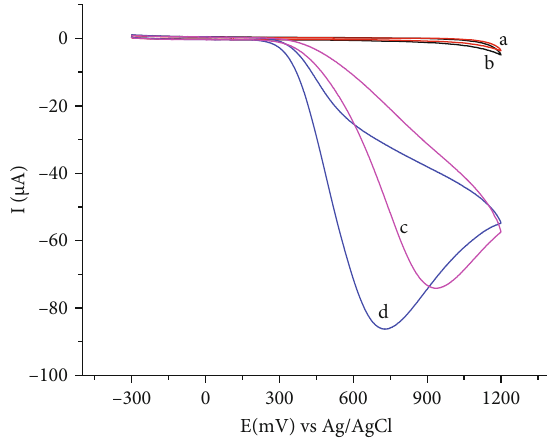
Figure 1: Cyclic voltammograms of (a) UCPE and (b) AQMCPE both in the absence of AA and (c) UCPE containing 2 mM AA and (d) AQMCPE containing 2mM AA in pH4 PBS at a scan rate of 100mVs − 1